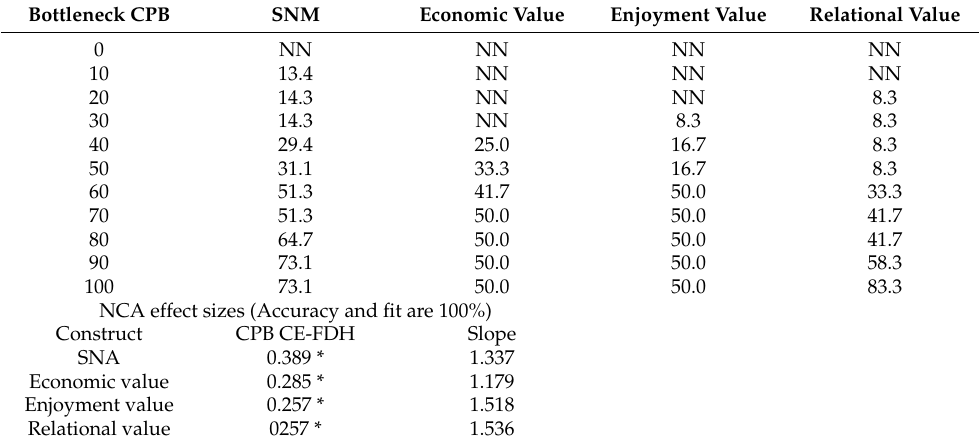
Table 8. Bottleneck table and NCA effect